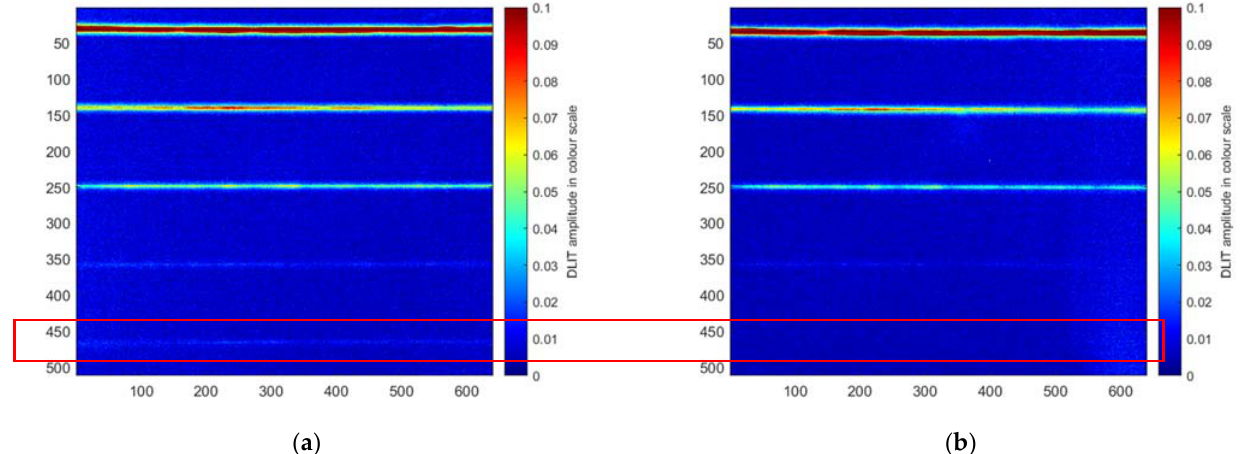
Figure 8. DLIT amplitude images of Test Sample 2 ( a ) without complete wire break; ( b ) with a com- plete wire broken on the fifth wire.